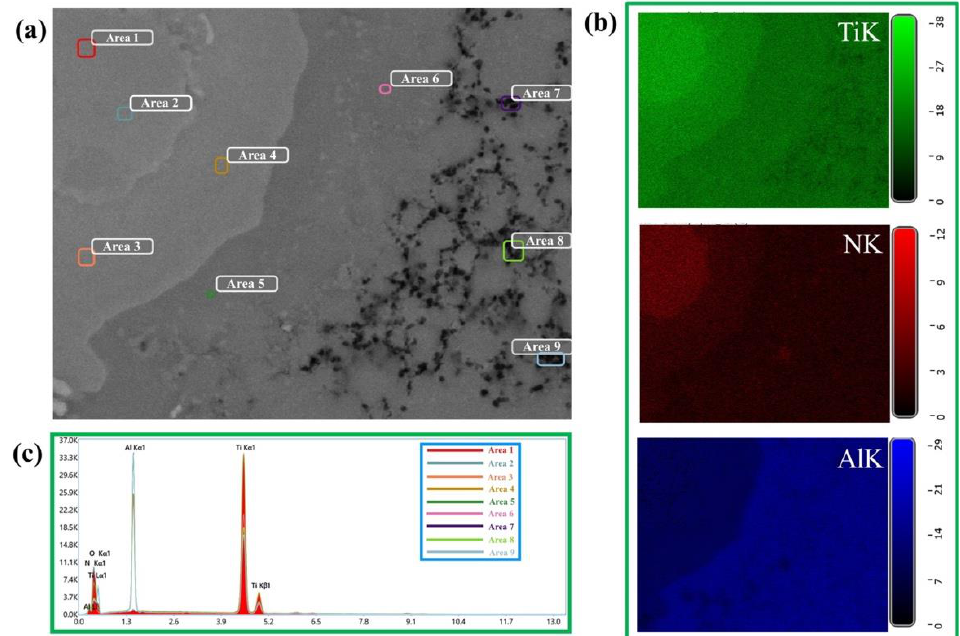
Figure 7. SEM image of the local materials area obtained by additive manufacturing via extrusion using a mixture of high-filled polymers (MEAM-HP) and Ti-Al intermetallide powders with subse- quent sintering at 1100 ± 20 ( a ), maps of the distribution of chemical elements in a local area of a composite particle ( b ), results of the energy dispersive analysis of the local areas in the structure of the materials ( c ). Table 2. Results of the energy-dispersive analysis of the local areas in the structure of the materials obtained by additive deposition from CrNi-TiN SHS composites using a mixture of high-filled polymers (MEAM-HP) and Ti-Al intermetallide powders with subsequent sintering at 1100 ± 20. transition via two routes